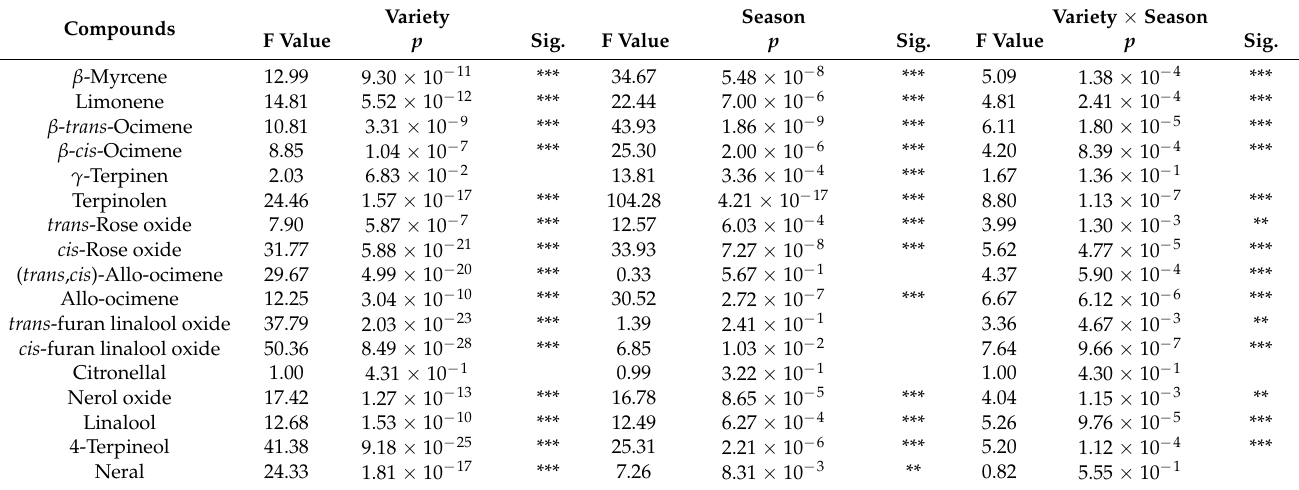
Table 3. Two-way ANOVA analysis of monoterpenoid concentrations in seven table grape varieties during the development of